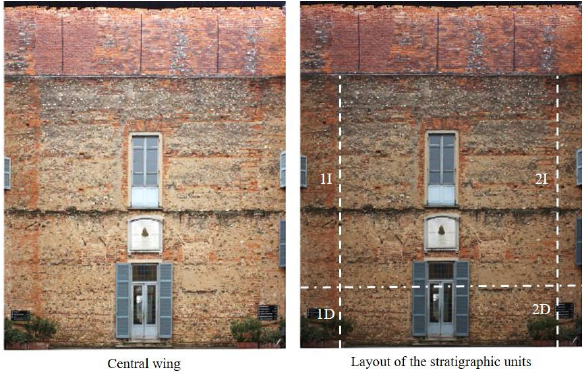
Figure 13. Localization of sampling areas in Palazzo Trotti, Courtyard façade, according to USM (1 and 2) and Direct (D) and Indirect (I) measurements.